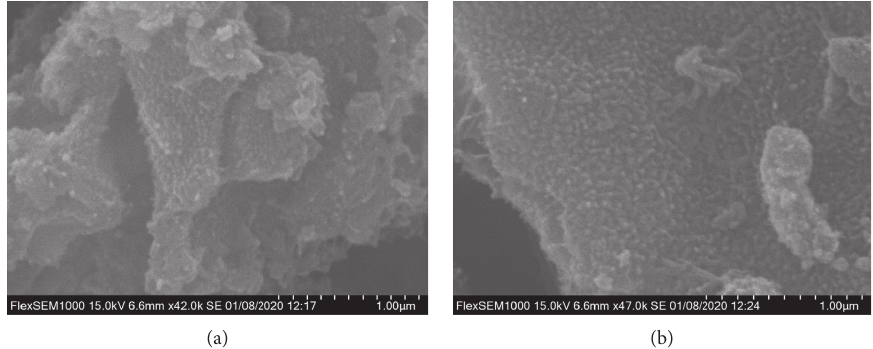
Figure 5: SEM images of (a) PANI/GO and (b) PANI/GO/Azo.